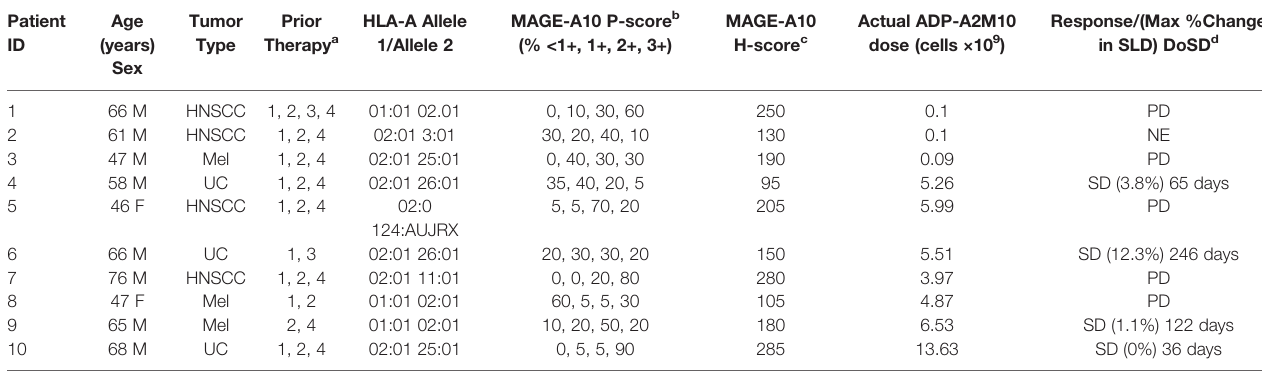
TABLE 2 | HLA and MAGE-A10 expression, ADP-A2M10 dose, and response in individual patients (mITT) with various tumor types at screening. Patient